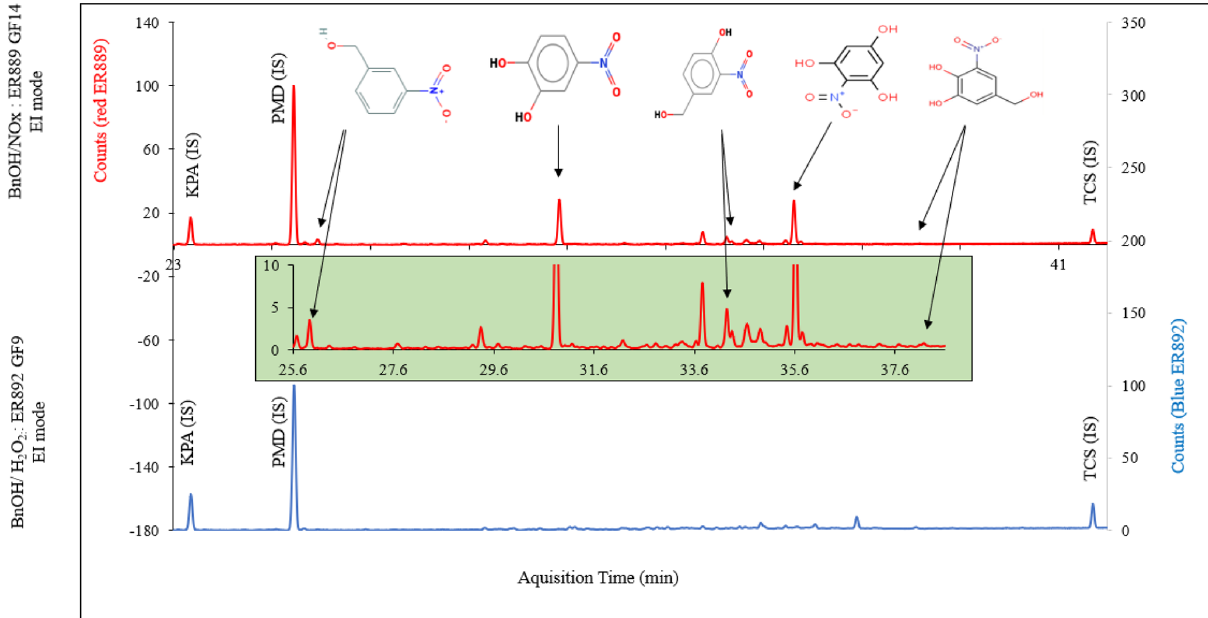
Figure 7. Portion of GC-MS extracted ion chromatograms (EI mode) at m/z 210, 165 (IS), 299 (IS), 300, 298, 372, and 388 associated with nitro-aromatic compounds merged in one chromatogram: (red) BnOH in the presence of NO x (ER889); (blue) BnOH in the presence of H 2 O 2 and absence of NO x